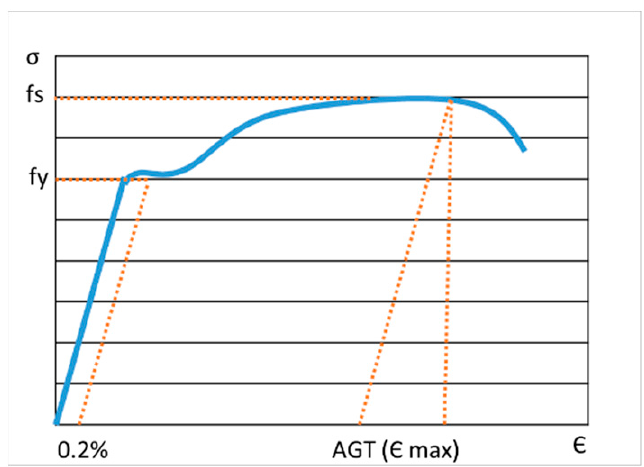
Figure 1. Stress–strain curve. fs: Ultimate strength, fy: Yield strength.